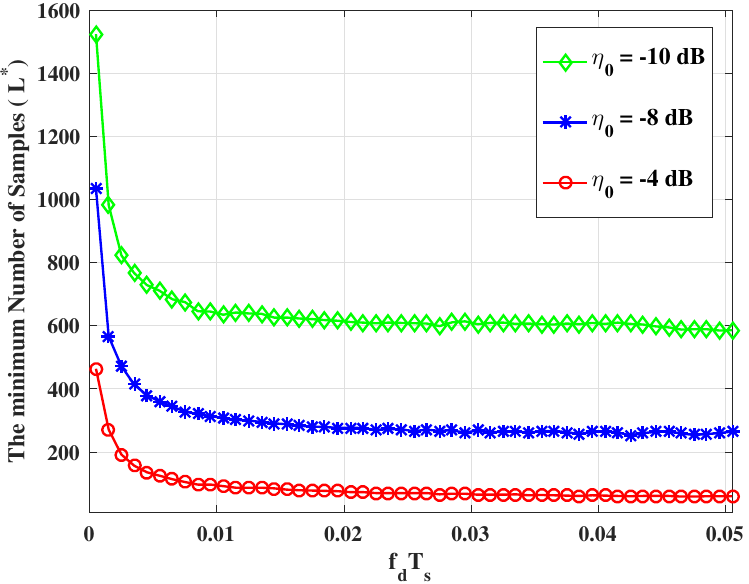
Figure 5. The minimum number of sampling observations required to come up to an expected detecting performance for local sensing ( N = 1, ξ 1 = 0.1, ξ 2 =